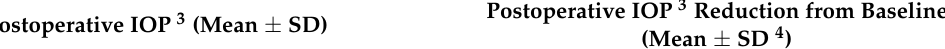
Table 3. Postoperative IOP values and IOP reduction after ns PMS and is PMS implantation at each follow-up.